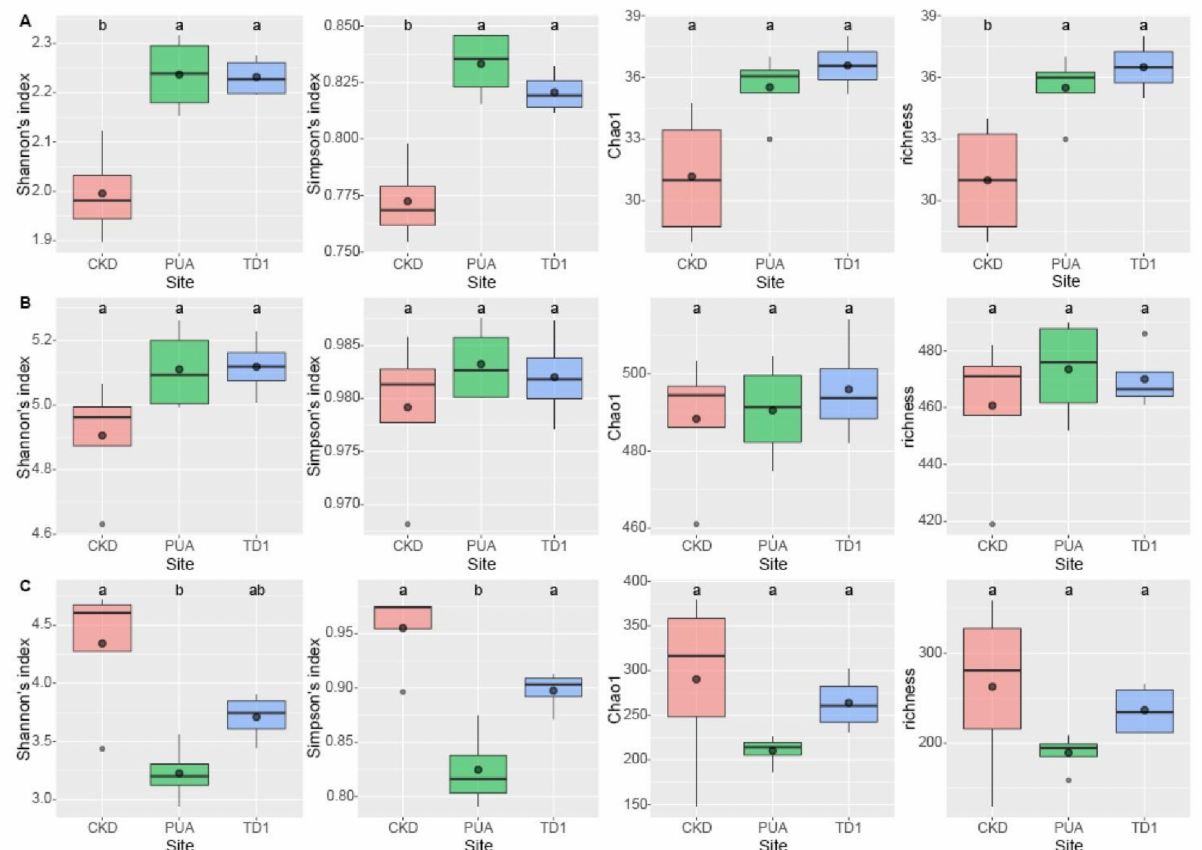
Figure 5. Boxplots of Alpha-diversity indices included Shannon’s index, Simpson’s index, Chao1, and richness (number of identifiable taxa) of Cladophora microbiomes collected from Nan River, Thailand. ( A ) Bacterial phyla. ( B ) Bacterial genera. ( C ) Eukaryotic genera. Different lowercase letters indicated statistically significant differences using Tukey’s HSD at a significant level of p <